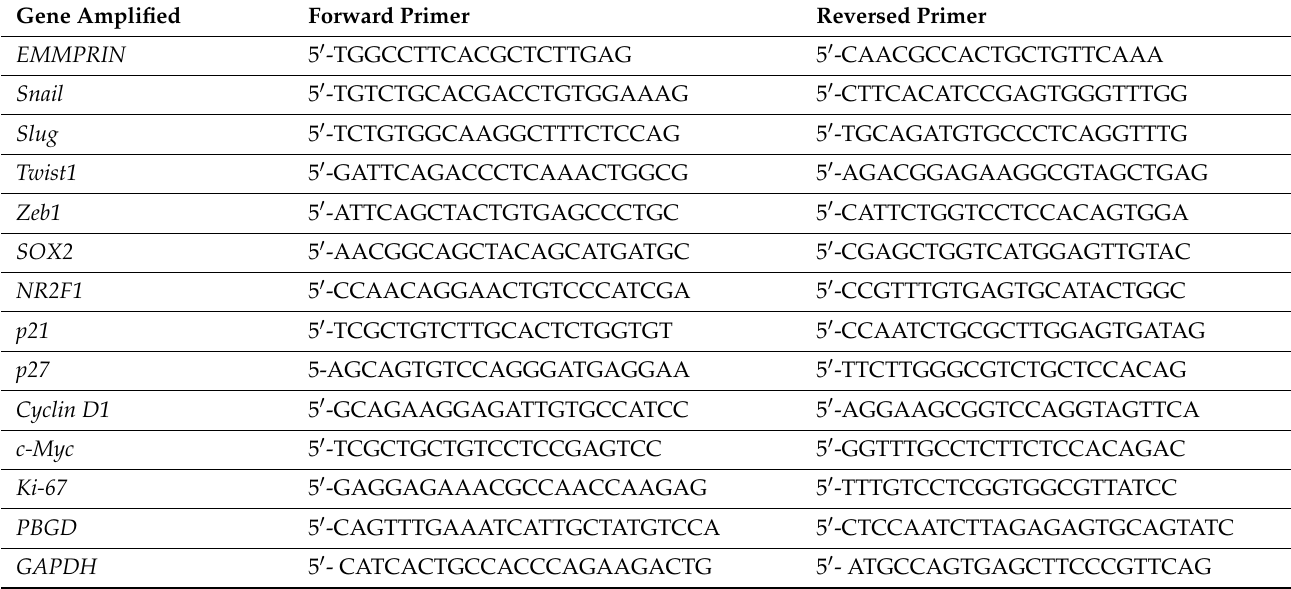
Table 1. List of primers used for qPCR